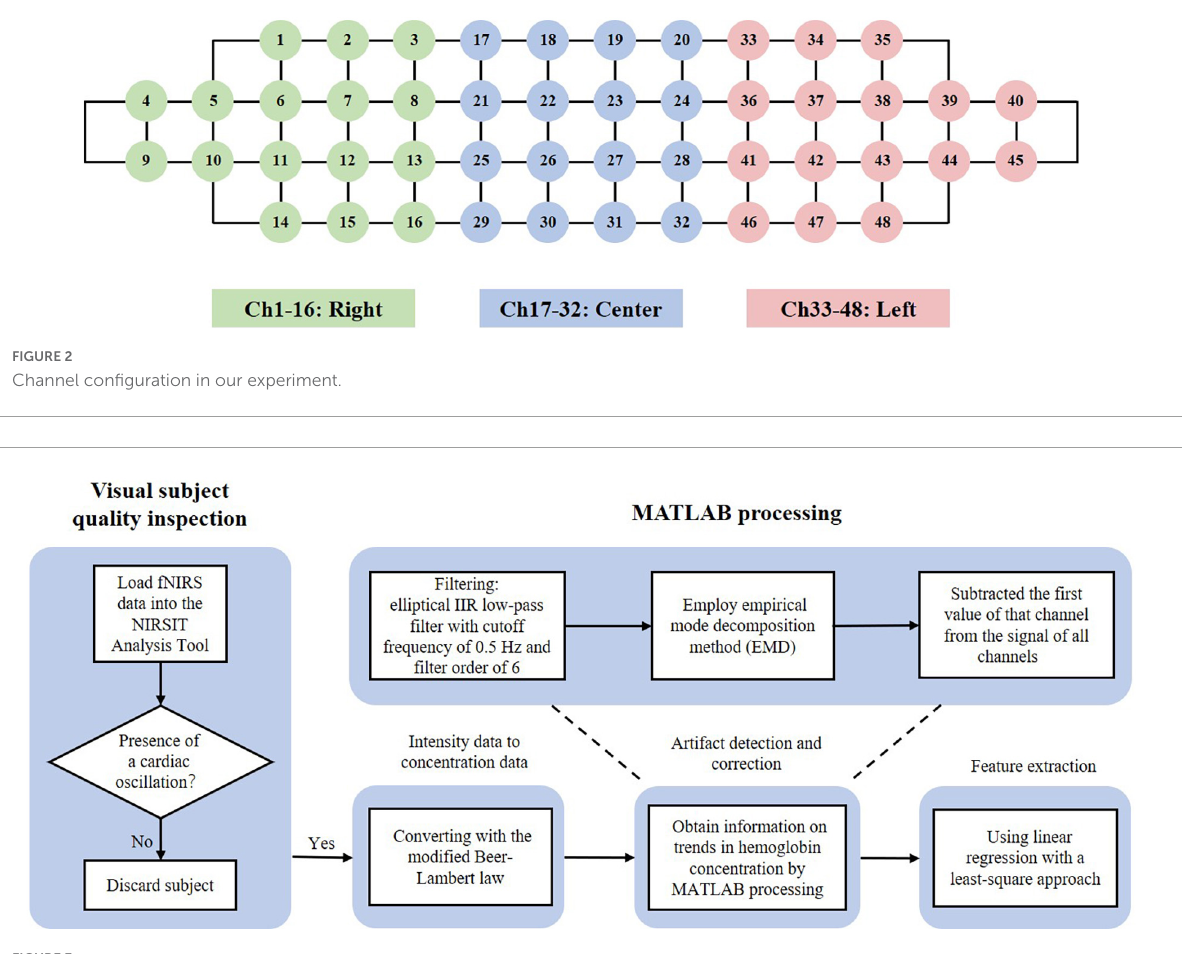
FIGURE3 Flow diagram of functional near-infrared spectroscopy (fNIRS) data pre-processing for the